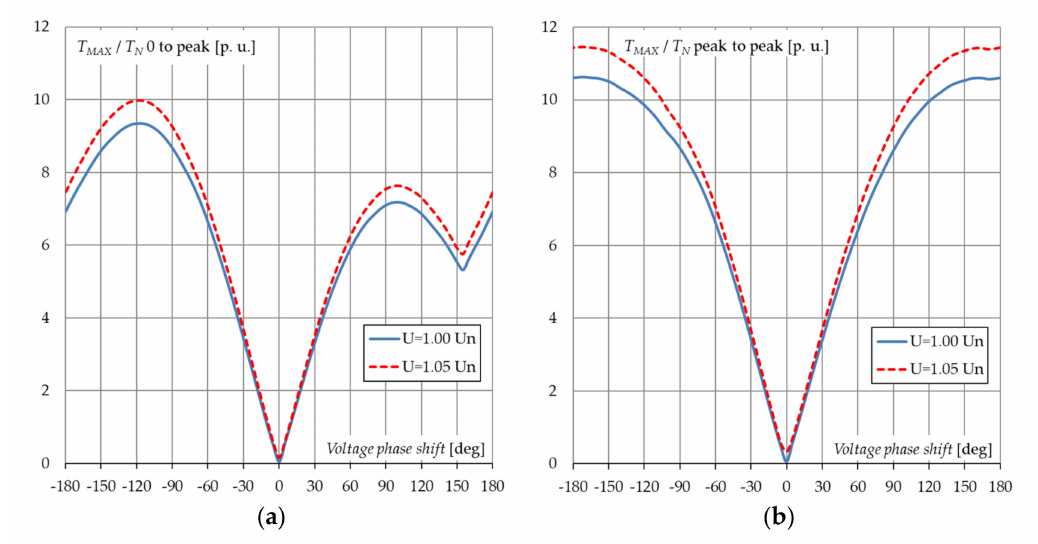
Figure 6. Maximum amplitude of electromagnetic torque ( a ) and absolute sum of two maximum electromagnetic torques with opposite directions ( b